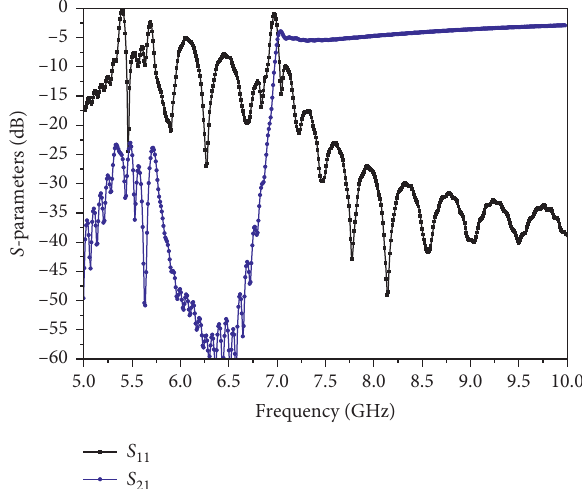
Figure 5: Scattering parameters for the proposed CRLH